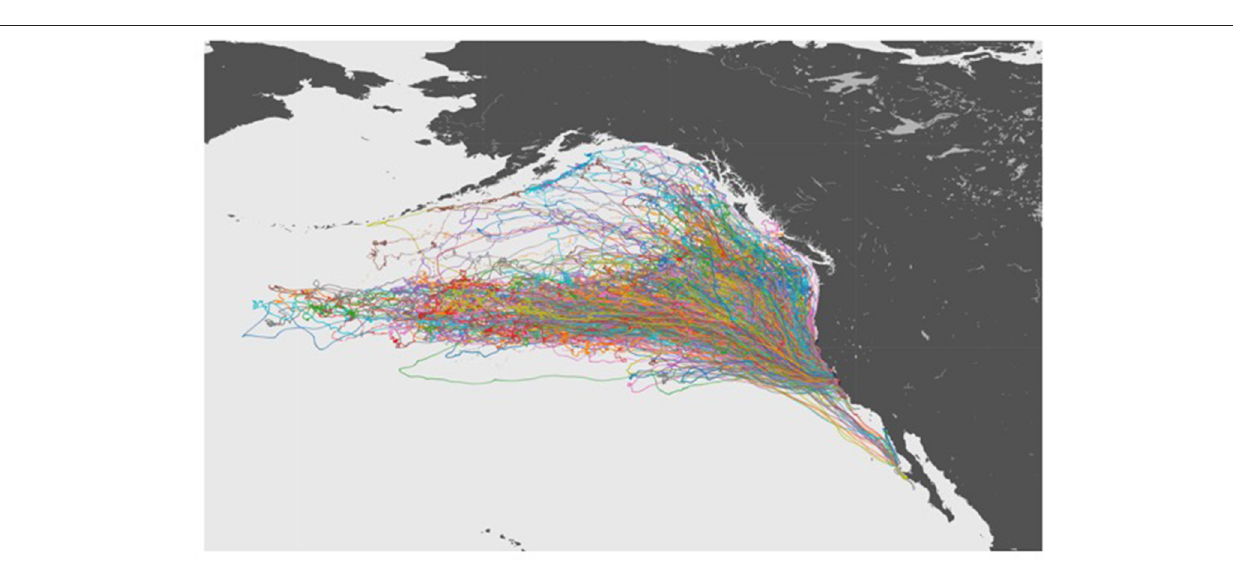
FIGURE 3 | A visualization of tracks for all of the 321 Elephant Seals migrating across the Northeastern Pacific